Question: What kind of plot is shown here?
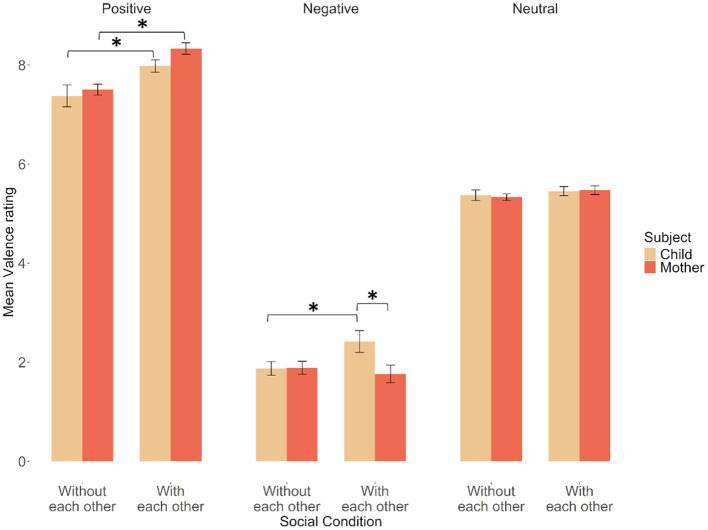
Answer: bar